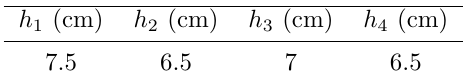
Table 1: Water levels in the quadruple tank for the se- lected operating